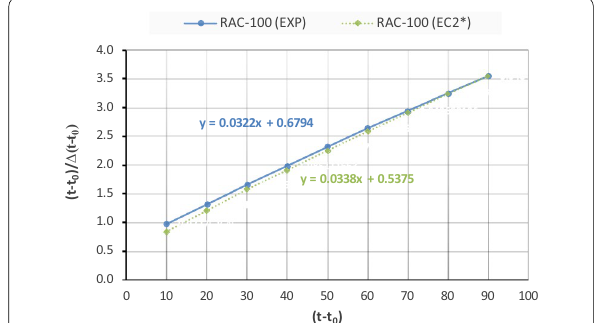
Fig. 13 Hyperbolic relations proposed by Ross for extrapolating the results of